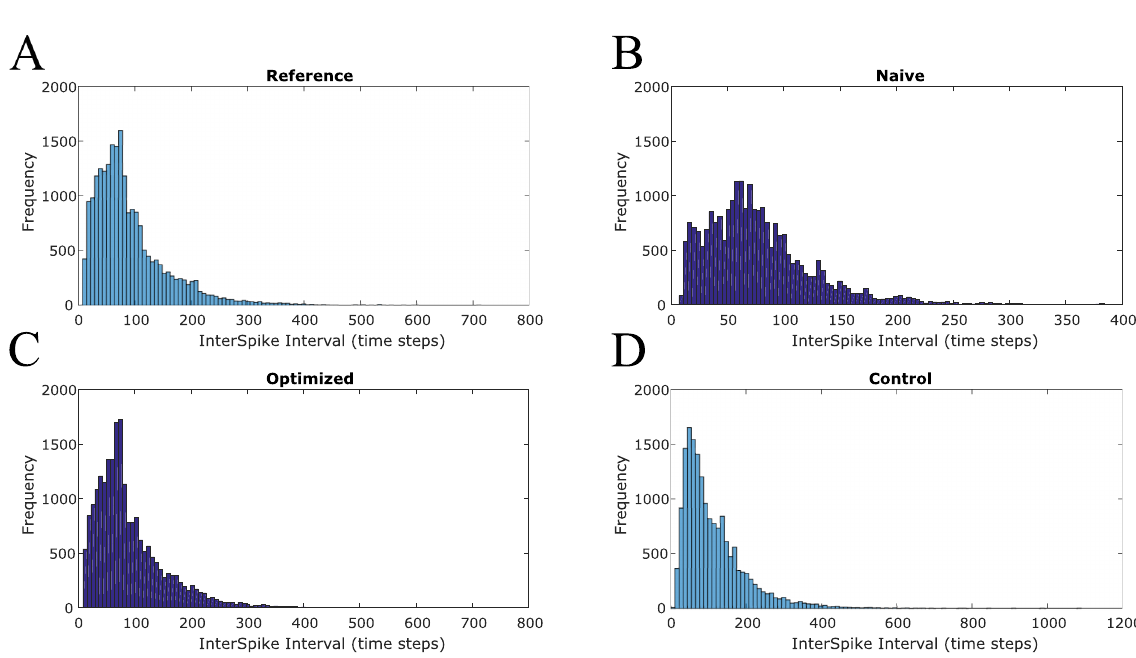
Fig 6. PSPM decreases distance measures for all initial network configurations. ( A ) Pairwise D measures from 30 trials for where initial weight matrix magnitudes were drawn from a uniform distribution on (Methods). Moving from left to right in each panel, distances are shown for the naive N (left), optimized O (middle), and control C network outputs (right). ( B ) Distance measures for a reference weight distribution with magnitudes drawn from a gaussian distribution (see Methods). ( C ) Distance measures for sparse initial configuration. ( D ) Distance measures for reference outputs produced from a naive-half-max initial configuration (Methods). Note that in each of these figures the optimized distances are consistently smaller than those of the naive or control, indicating successful learning due to PSPM prescribed weight changes.